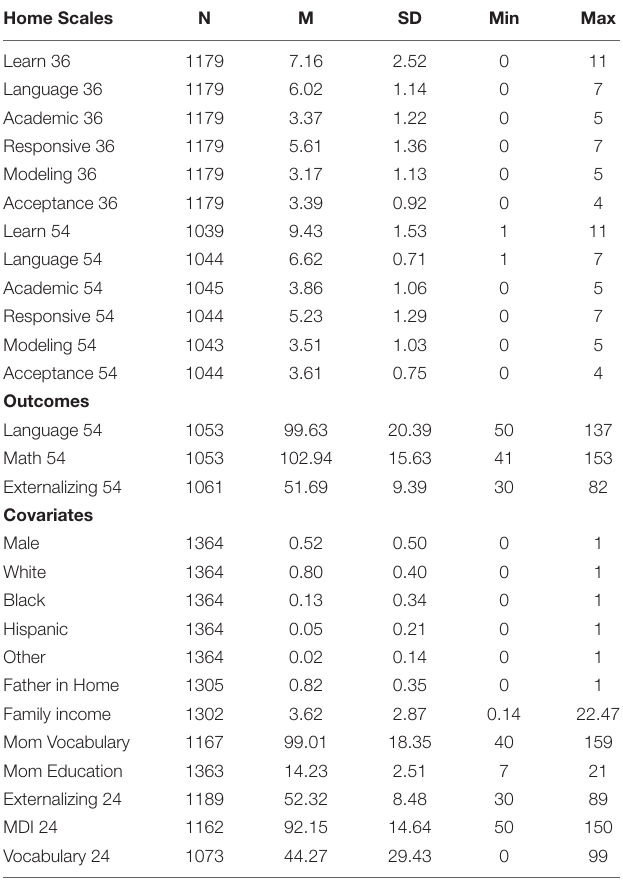
TABLE 1 | Descriptive statistics for variables included in the study. scores have a normed mean of 100 and a standard deviation of 15 and were used in this